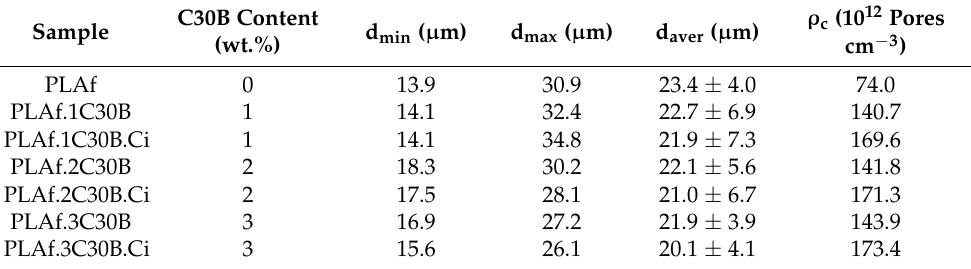
Table 1. Pore diameters (d) and cell densities ( ρ c ) of the PLA nanocomposite